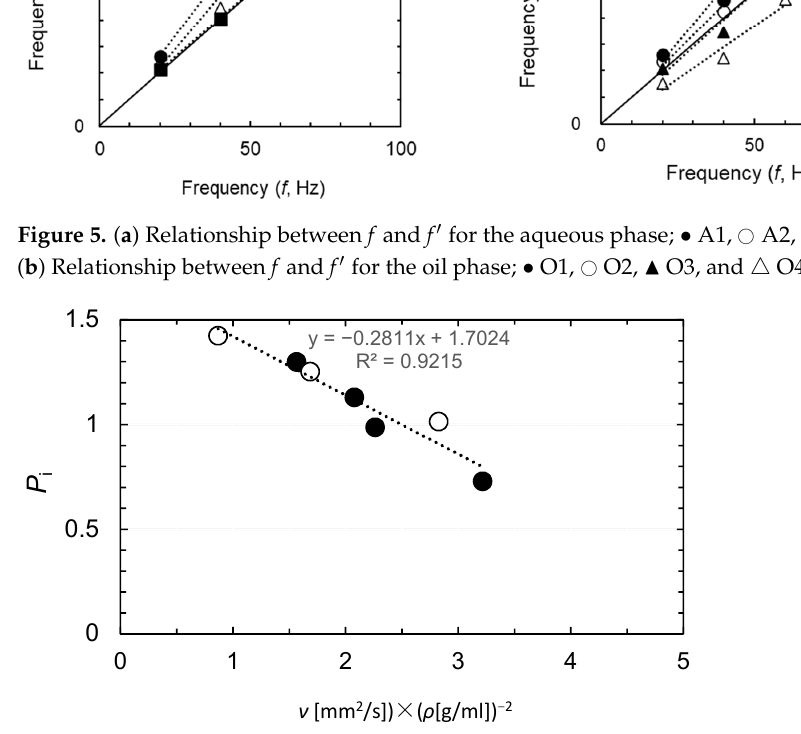
Figure 6. Effect of the kinematic viscosities of the oil and aqueous phases on parameter P i ; • oil phase; ○ aqueous phase.